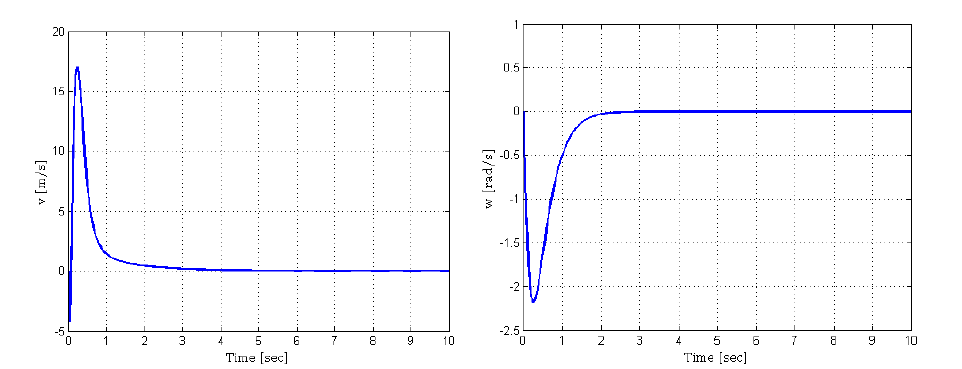
Figure 8. Posture stabilization (forward parking with initial heading angle at 90 ◦ ): linear velocity v (m/s) and angular velocity ω